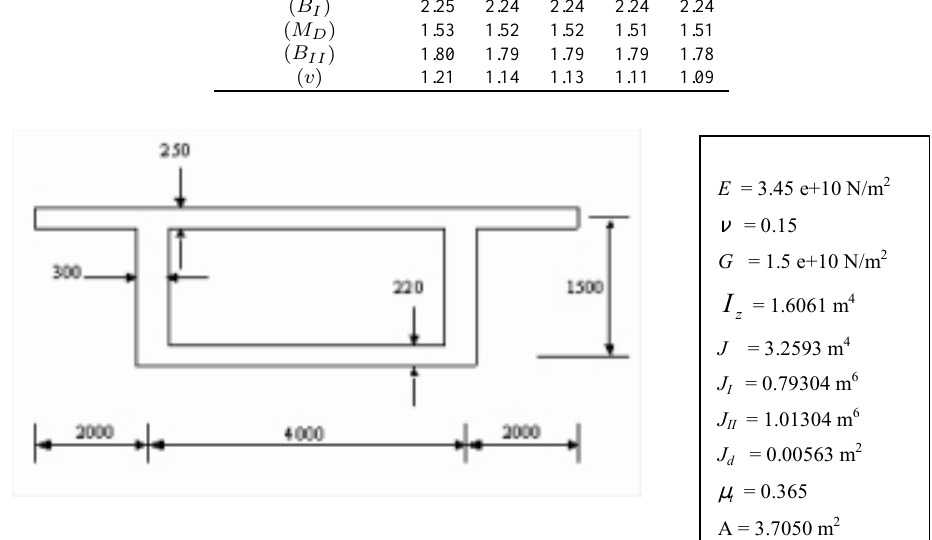
Fig. 8. Geometry (mm) and properties of box girder bridge.